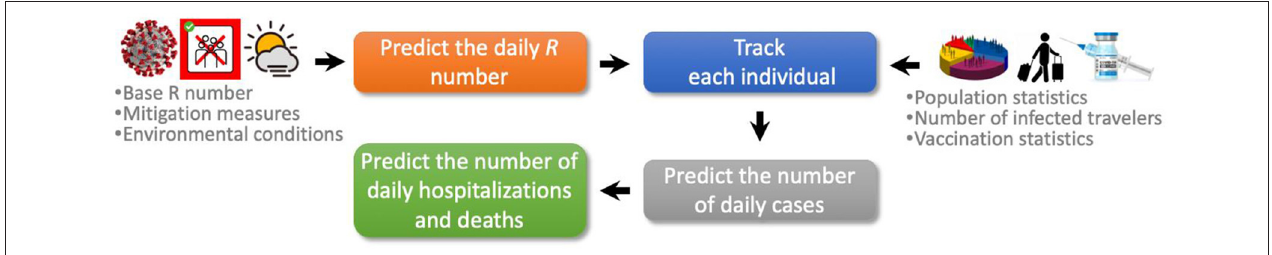
FIGURE 1 | Proposed COVIDHunter model for simulating COVID-19